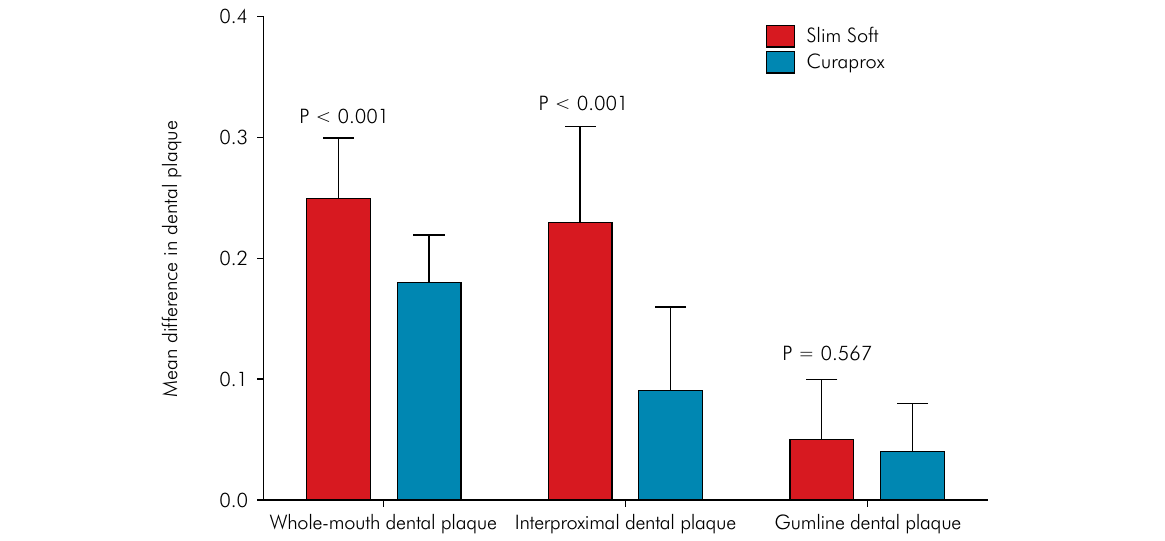
Figure 3. Mean differences in plaque scores from 7-day pre-brushing to 7-day post-brushing. P values refer to inter-group comparisons (analysis of